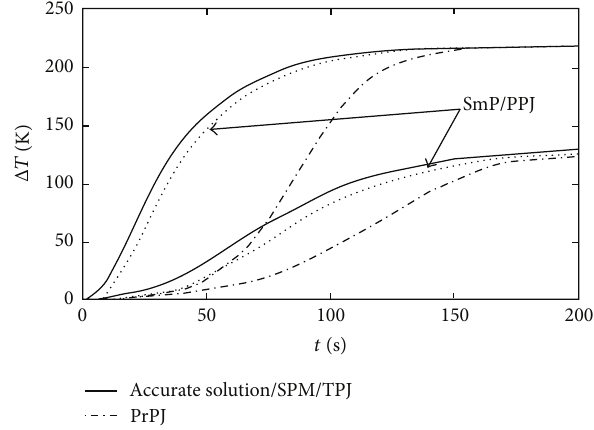
Figure 3: Variation of temperature rise of reactor with time while inserting step reactivity 𝜌 0 = 0.5𝛽 and 𝜌 0 = 0.8333𝛽 .